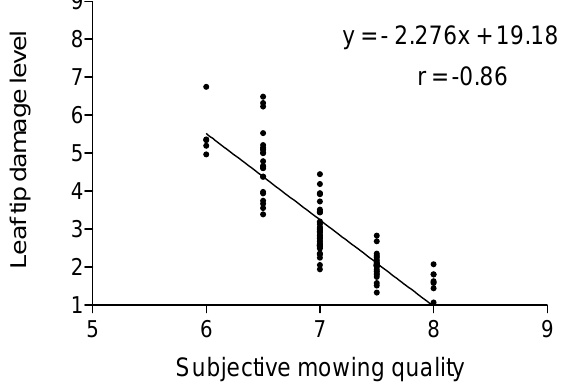
Figure 7. Bermudagrass leaf tip damage level (Equation (1)) and subjective mowing quality (1 = poor, 9 = excellent) correlation and Pearson’s correlation coefficient (r). All replicates are reported.